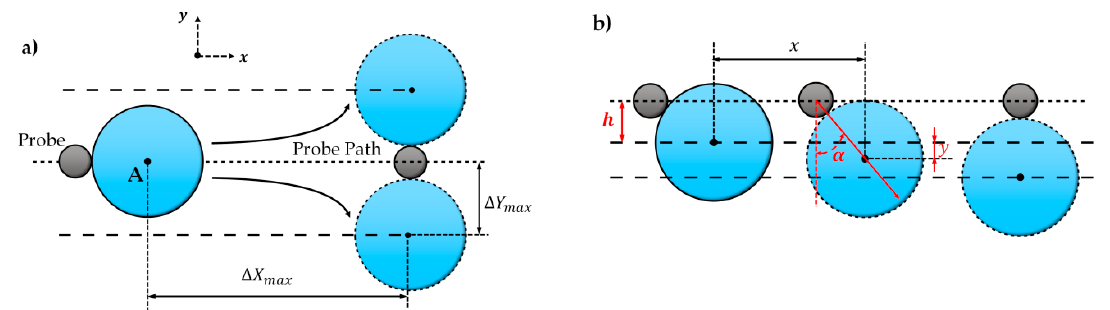
Figure 3. Single-step microparticle trajectories with different contact positions. ( a ) The microparticle center locates on the tip push path. ( b ) The microparticle center deviates from the tip push path. α is the angle between the vertical direction and tip–microparticle link line, denoting the transient moving direction of the microparticle. h is the initial vertical distance between the microparticle and tip push path. Point Zero locates at the initial position of the microparticle.